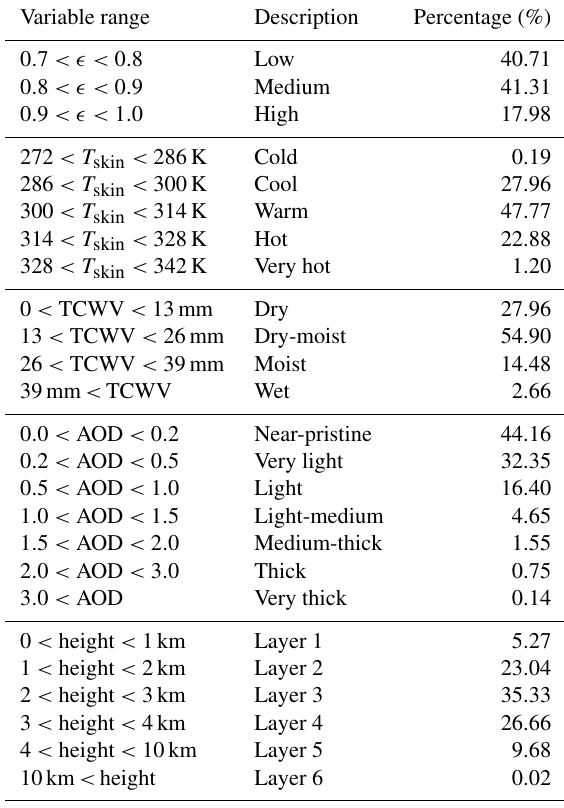
Table 2. Distribution of variables within their specified ranges. (cid:15) is the emissivity at 8.7µm, T skin is the skin temperature, and TCWV is the total column water vapour. The height refers to the dust height as specified by the median height of the AOD at 10.8µm. Within each variable set, the sum is 100%. The total number of points is approx- imately 15.8 million, the maximum value of TCWV is 53.0mm, the maximum simulated AOD is 14.8 (0.007% of points have an AOD greater than 5), and the maximum defined height is 19.7km. The maximum AOD of points within Layer 6 is